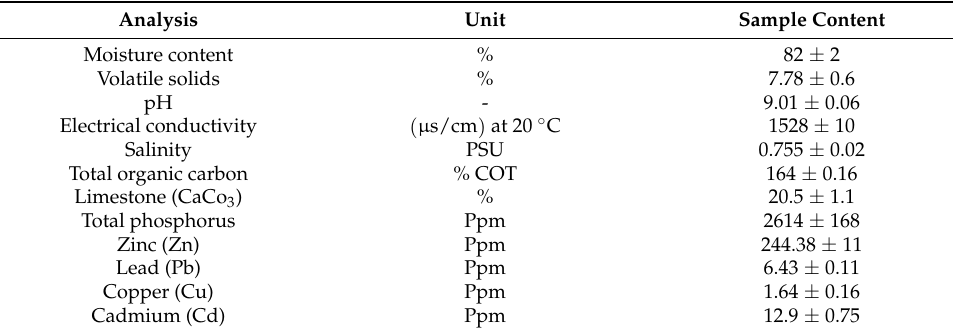
Table 2. Characteristics of fresh PHWWC